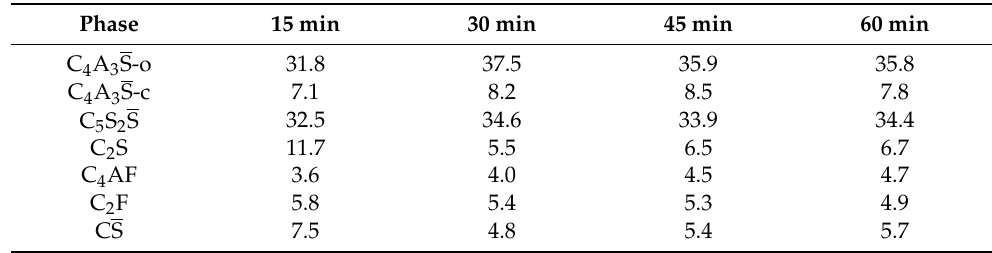
Table 7. Quantitative mineralogical compositions of clinker B sintered at 1150 ◦ C for different retention times (wt.%).